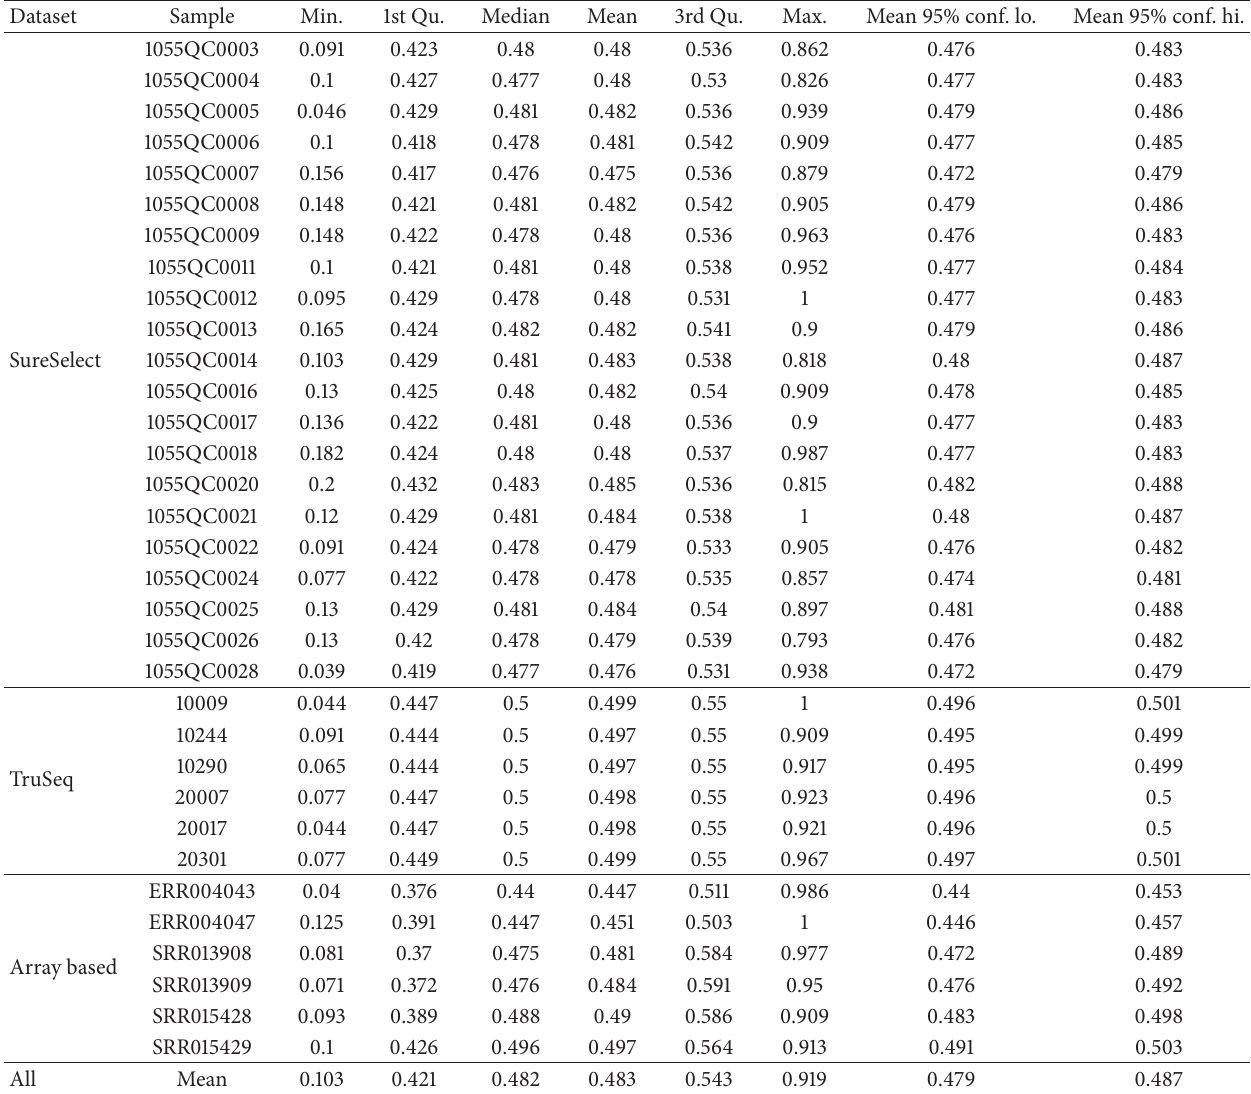
Table 1: Allele balance for 3 independent